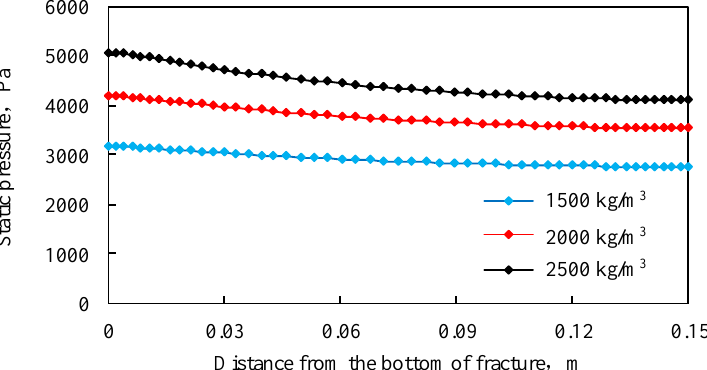
Figure 7. Static pressure distribution under different proppant densities: (a) 1500, (b) 2000, and (c) 2500 kg/m 3 .